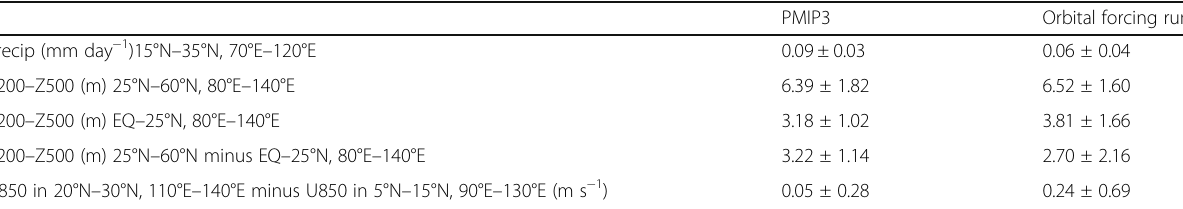
Table 3 Seasonal differences (ASO minus AMJ) and 95% confidence intervals for precipitation (mm day − 1 ), tropospheric thickness (between 200 and 500 hPa levels; m) over Asia, and an East Asian-Western North Pacific monsoon index, the meridional gradient of zonal wind at the 850 hPa level (Wang et al. 2008) during the MWP relative to the LIA. PMIP3 (orbital forcing run) row represents a 10-model ensemble mean (5-member ensemble mean for the MRI-CGCM2.3 orbital forcing run) PMIP3